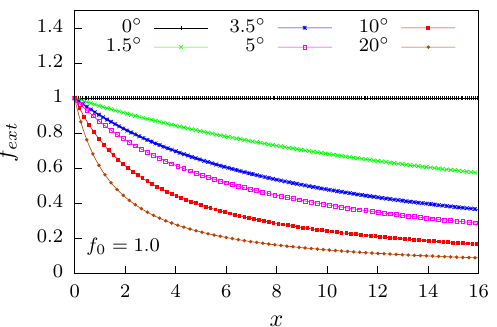
Figure 2. External force f ext as a function of the length of the channel along its axis x , plotted for different apex angles α at a fixed f 0 = 1.0 according to Eq. (5). With increasing α , external force drops rapidly with x as